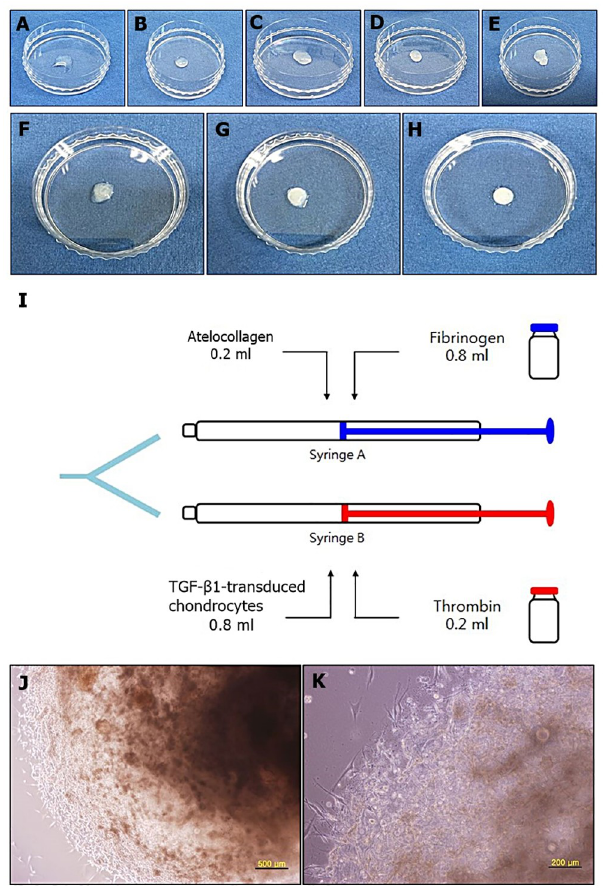
Fig 1. Determination of the thrombin and TGF- β 1-transduced chondrocytes mixing ratio. (A) The mixture comprising 0.9 ml of TGF- β 1-transduced chondrocytes and 0.1 ml of thrombin did not retain the shape of the beads and flowed down. (B) The mixture comprising 0.8 ml of TGF- β 1-transduced chondrocytes and 0.2 ml of thrombin maintained the bead shape well and became firm at approximately 30 s. Mixtures comprising different ratios of TGF- β 1-transduced chondrocytes and thrombin: (C) 0.7 ml of TGF- β 1-transduced chondrocytes and 0.3 ml of thrombin, (D) 0.6 ml of TGF- β 1-transduced chondrocytes and 0.4 ml of thrombin, and (E) 0.5 ml of TGF- β 1-transduced chondrocytes and 0.5 ml of thrombin exhibited rapid bead formation. Manipulating these beads was difficult. Determination of the fibrin and atelocollagen mixing ratio: (F) mixing ratios of 0.6 ml of fibrin and 0.4 ml of atelocollagen, (G) 0.7 ml of fibrin and 0.3 ml of atelocollagen (failed to maintain the bead shape at approximately 30 s), and (H) 0.8 ml of fibrin and 0.2 ml of atelocollagen (maintained the bead shape well at around 30 s). Determination of the mixing ratio of TGF- β 1-transduced chondrocytes, thrombin, atelocollagen, and fibrin mixture: (I) Two syringes were prepared as one set of injection, and four sets of injection were prepared. Microscopic findings of TGF- β 1-transduced chondrocyte-atelocollagen mixture: TGF- β 1-transduced chondrocytes were well distributed in the atelocollagen mixture beads, and the round shape of the beads was well maintained after 21 days of culture. Cells exhibited proliferation activity around the mixture beads. (J) × 40 (K) ×